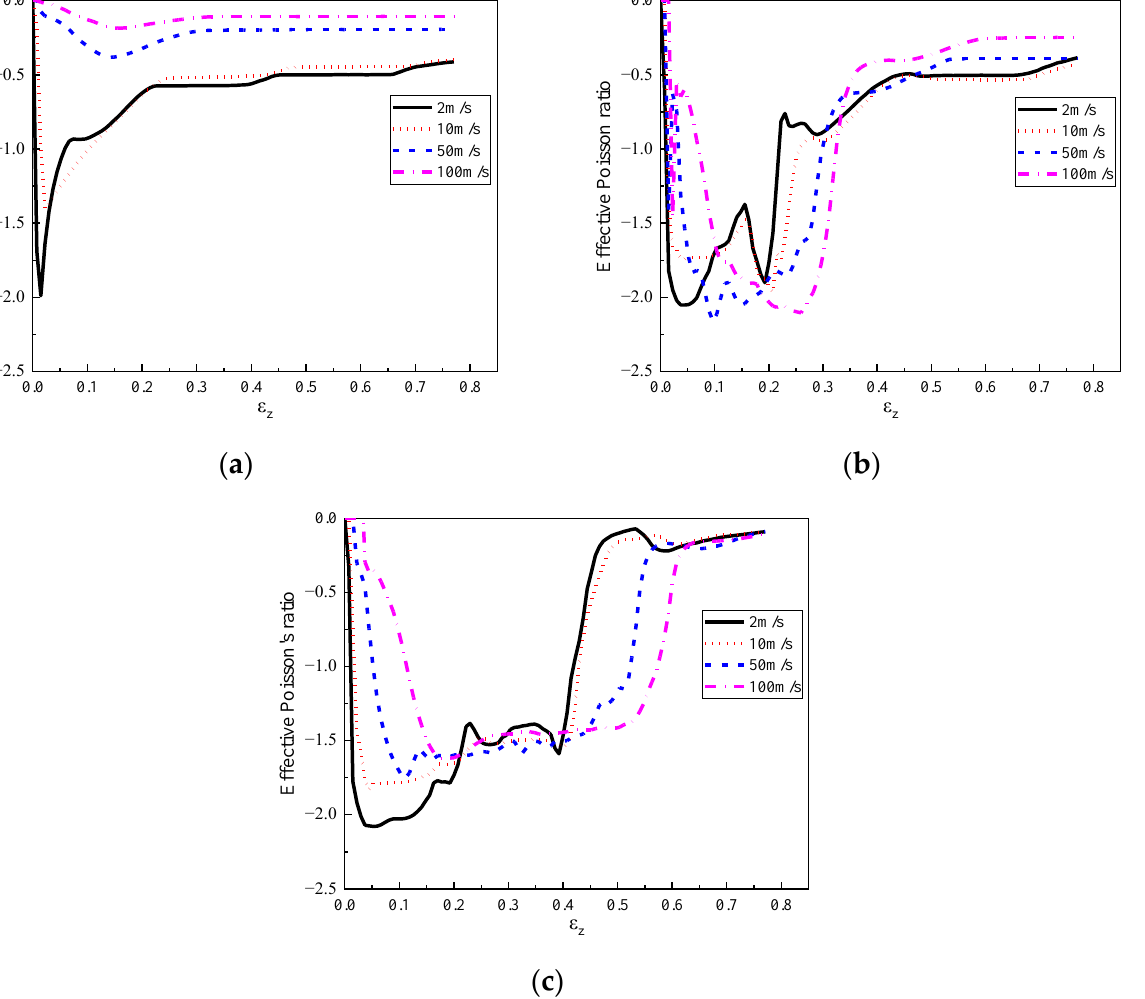
Figure 31. The effective Poisson’s ratio of the composite ( t = 0.4:0.4:0.4 and ρ = 408:575:848) at loading rates of 2 m/s, 10 m/s, 50 m/s, and 100 m/s: ( a ) top layer; ( b ) middle layer; ( c ) bottom layer.